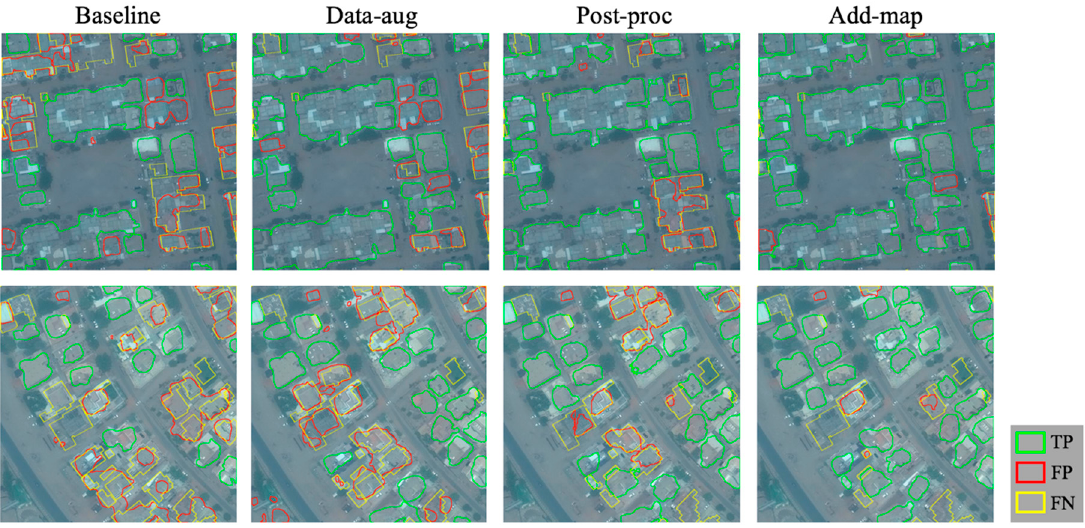
Figure 8. Examples of building extraction results for Shanghai using different strategies.